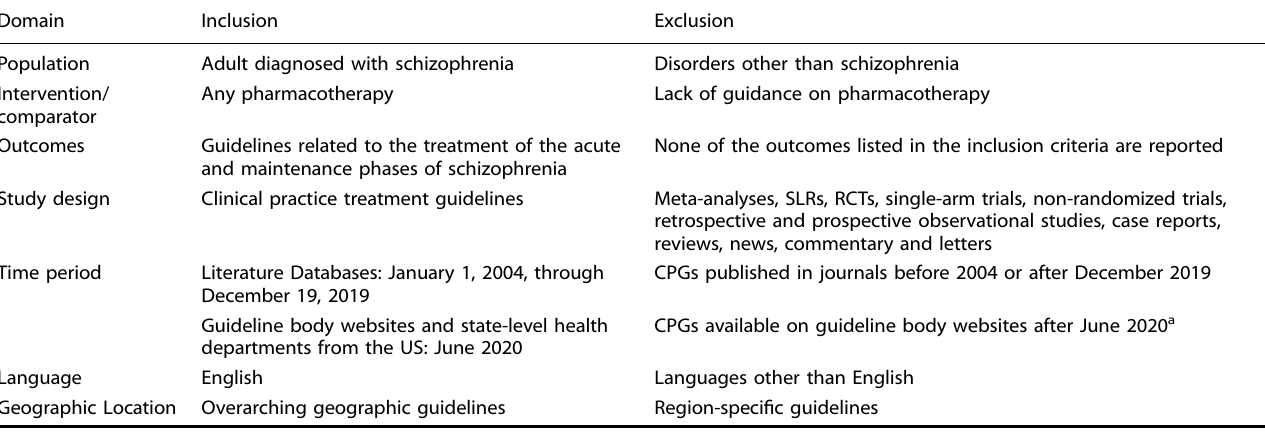
Table 4. Study selection